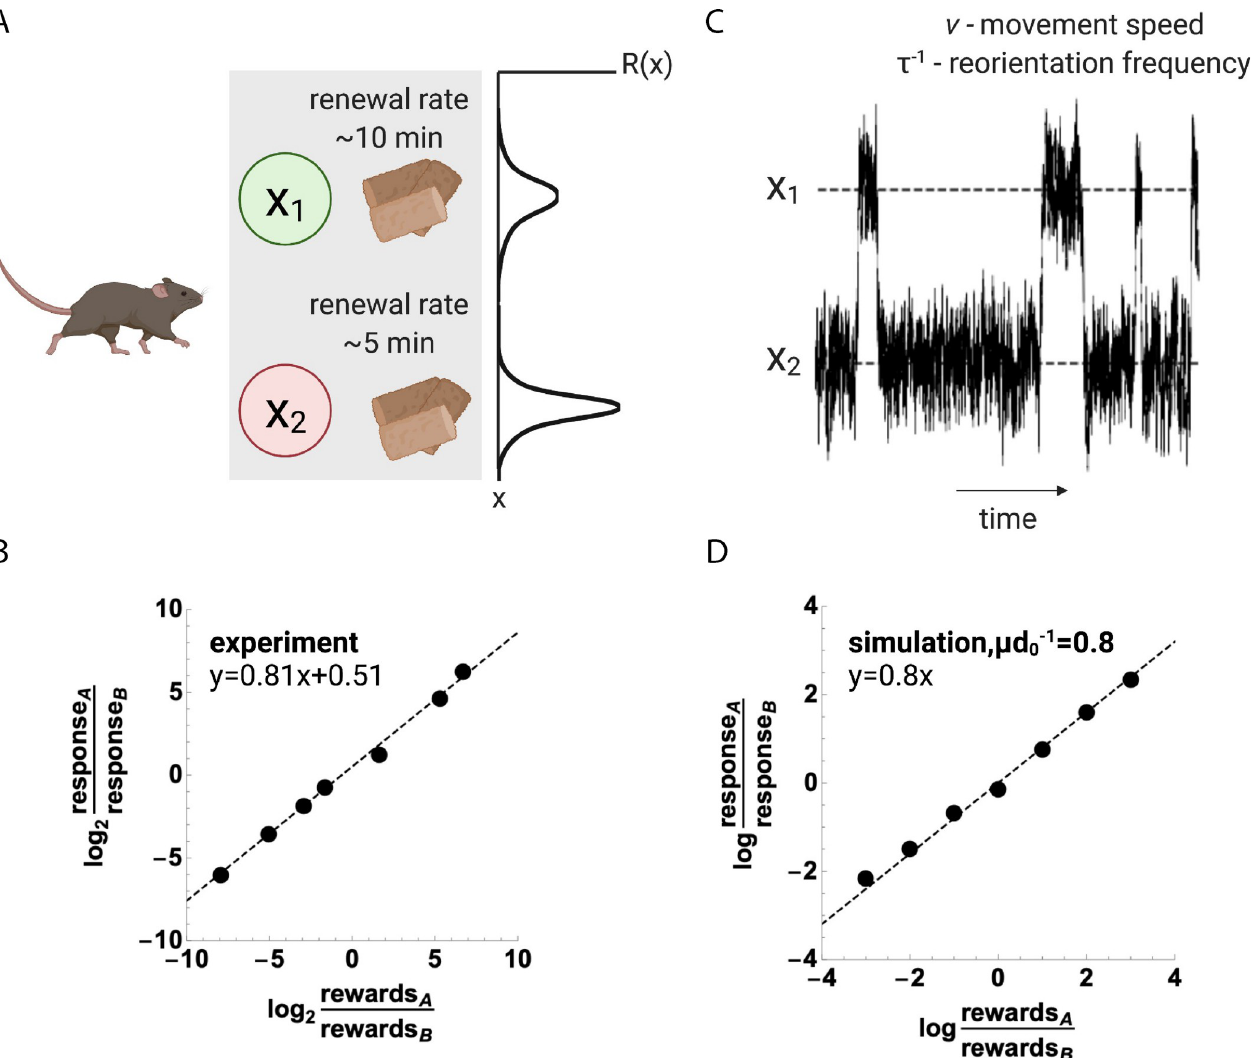
Fig 3. Reward-taxis model provides the generalized matching law. (A) Matching is observed in experiments where the animal can harvest rewards from two locations, which may be baited or empty. Following the consumption of the reward, the location becomes re-baited after some random amount of time, which may be different between the locations. The generalized matching law, amply supported experimentally, is a power-law relation between the reward harvested � � b ¼ R 1 , R 1 , R 2 are rewards harvested at locations A = x 1 , B = x 2 . Perfect matching occurs for β = 1, while undermatching/ and the frequency of responses P ð x 1 Þ P ð x 2 Þ R 2 overmatching are due to variations in β . Undermatching, with β < 1, is often observed, as in (B) (data from Fig 1 of [65]). (C,D) To model stochastic choice behavior of a freely behaving animal, we use a random walk model where the animal moves at speed v and reorients at frequency τ − 1 , with v modulated by dopamine. Random walk model simulation for choice between two expected rewards R 1 , R 2 . Expected reward input field is the sum of two Gaussians: R x ð Þ